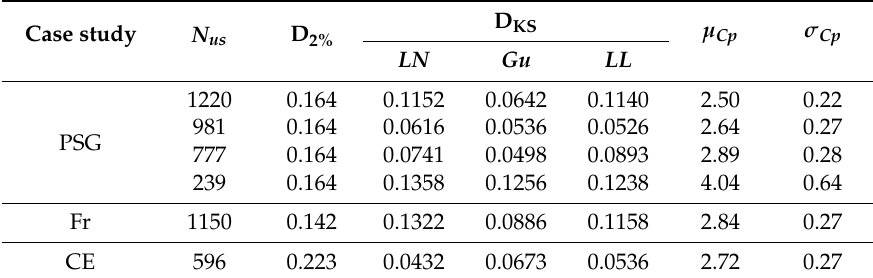
Table 2. Goodness of fit and statistics for the analyzed samples.